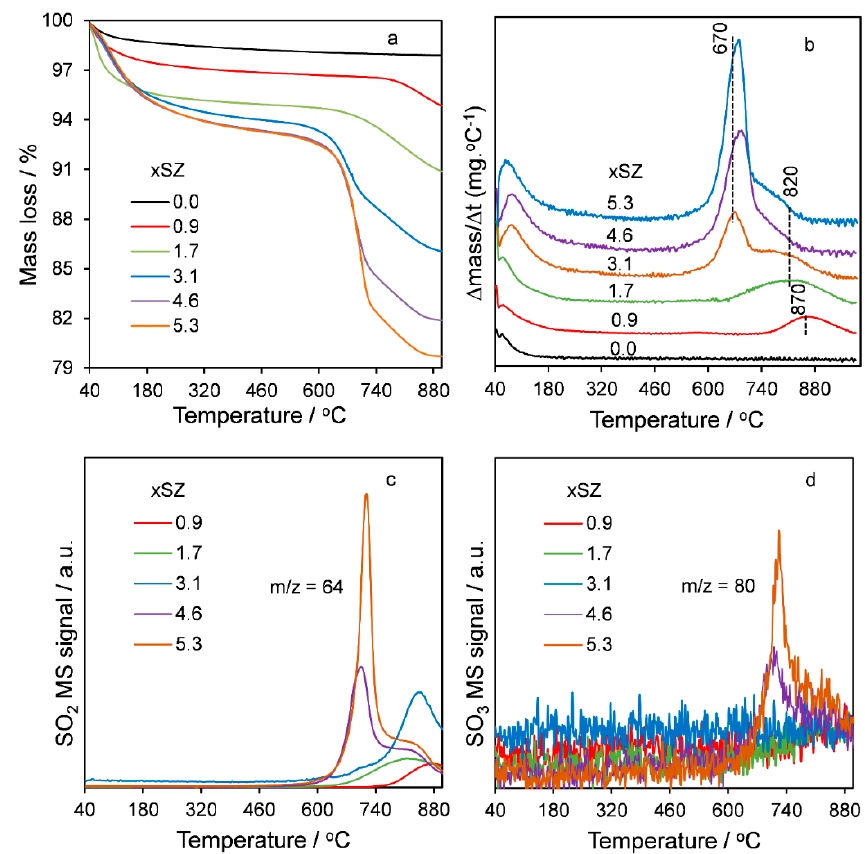
Figure 2. ( a ) TGA and ( b ) DTGA profiles, and temperature-programmed desorption spectra of evolved ( c ) SO 2 and ( d ) SO 3 from parent and sulfated zirconia as a function of bulk S loading. Table 2. Thermogravimetric-mass spectrometry of parent and sulfated zirconia. Mass Loss ( ± 0.1) (%) S Content (wt %) Evolved Species b 40–350 ◦